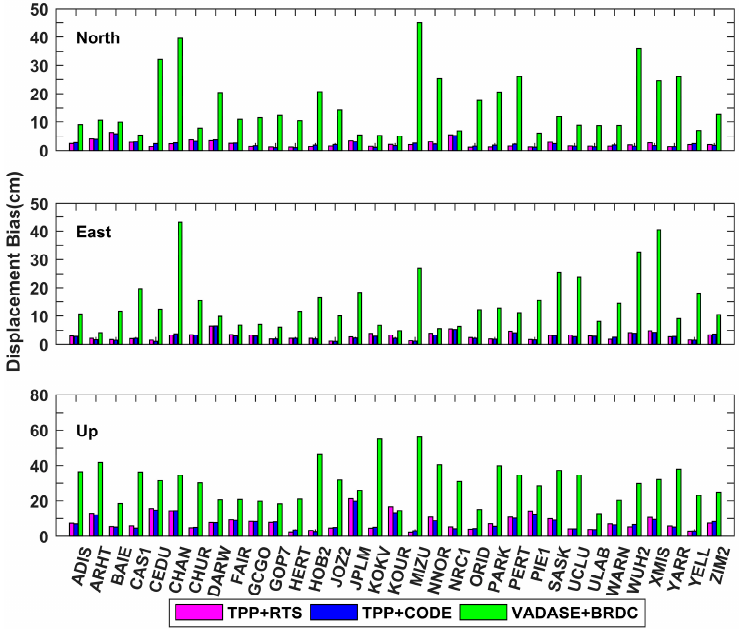
Figure 6. The average values of the derived displacements in north, east and up directions for different schemes at each station.